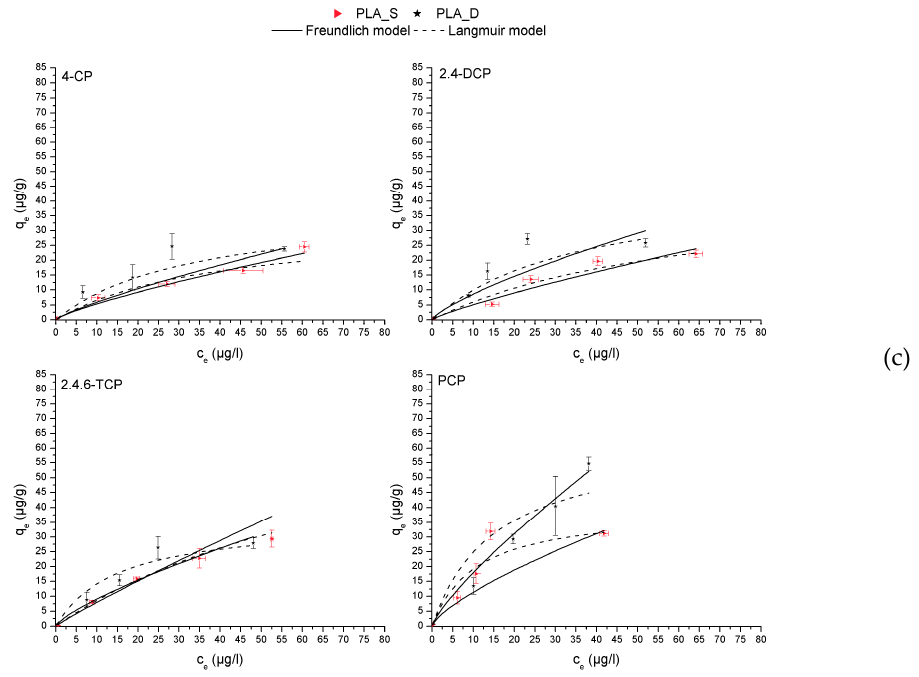
Figure 4. Sorption isotherms of 4-CP, 2,4-DCP, 2,4,6-TCP and PCP on ( a ) PEg, ( b ) PP and ( c ) PLA particles obtained for the synthetic matrix (PEg_S, PP_S and PLA_S) and Danube river water (PEg_D, PP_D and PLA_D) ( n = 3, mean value ± SD). Table 5. Values of the Freundlich and Langmuir model parameters for the sorption of 4-CP, 2,4-DCP, 2,4,6-TCP and PCP on PEg, PP and PLA. Compounds